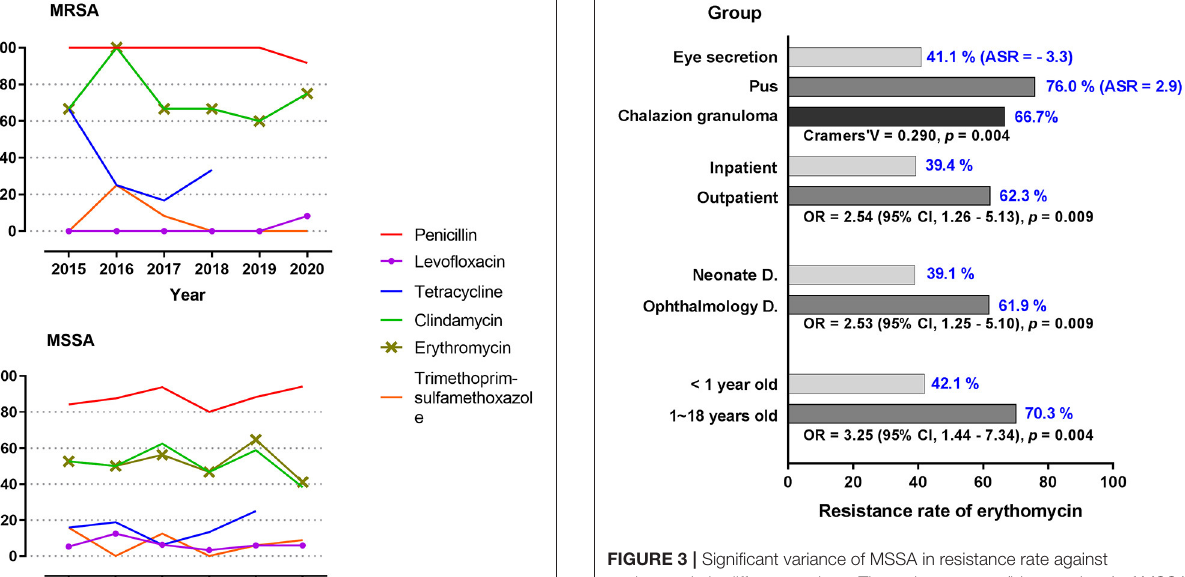
FIGURE 3 | Significant variance of MSSA in resistance rate against erythromycin in different settings. The resistance rate (blue numbers) of MSSA is stratified by groups of age, department, inpatient, and specimen. With the exception of adjusted standardized residuals applied for specimen, odd ratio and confidence interval are used to demonstrate significant differences in the groups. MSSA, methicillin-sensitive S. aureus ; D., department; ASR, adjusted standardized residuals; OR, odd ratio; CI, confidence